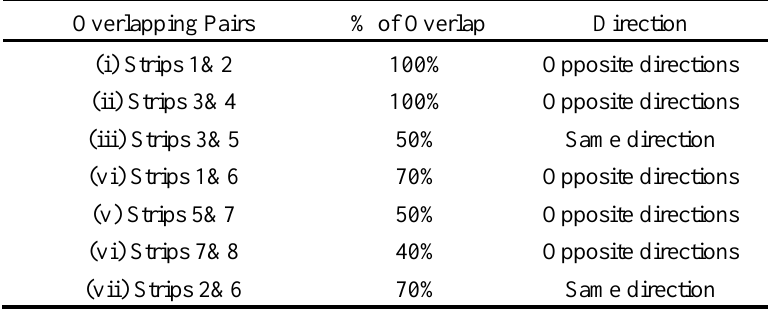
Table 1. Characteristics of the involved overlapping pairs in the proposed calibration procedures.